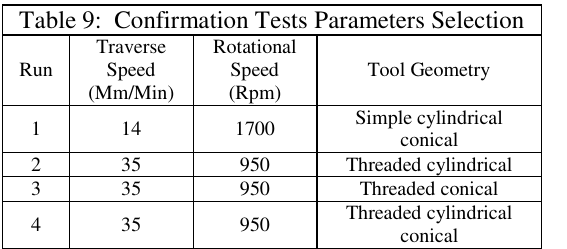
Fig. 17: Confirmation Test Samples